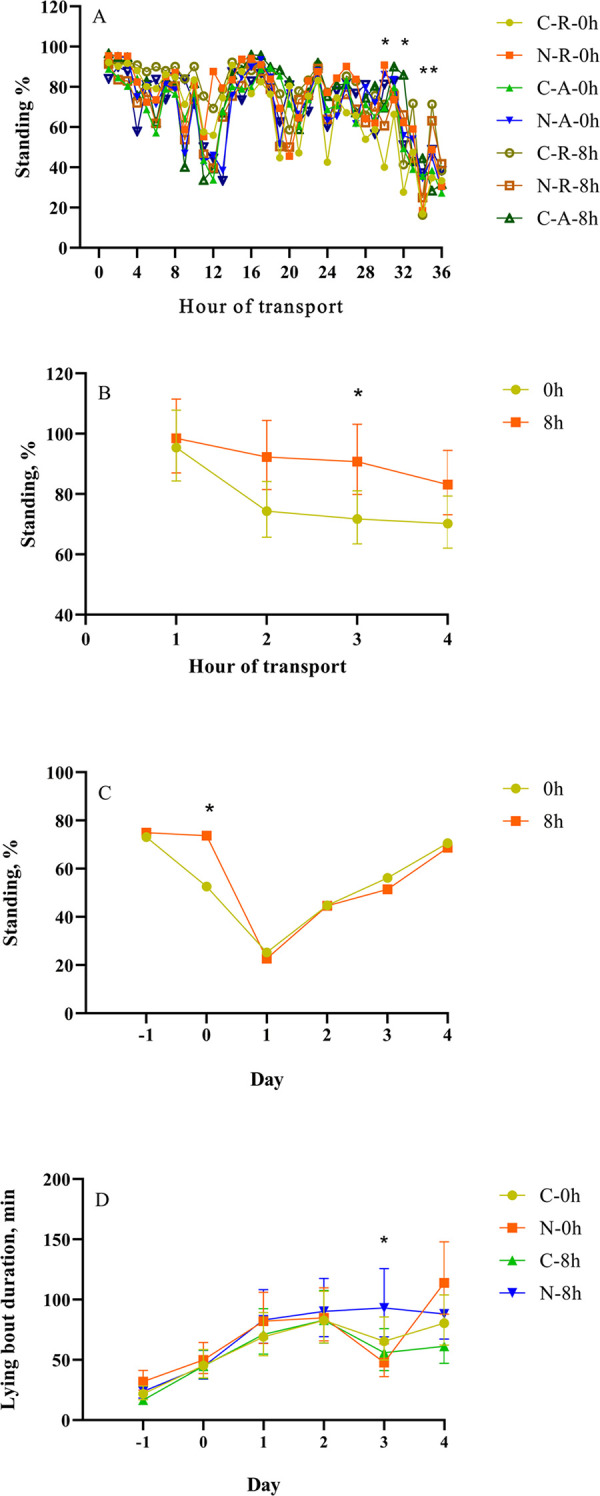
Least squares means (± upper and lower limits at 95% confidence) of standing duration (% of time) during the (A) 36 h transport, (B) additional 4 h transport, (C) first 4 days after transport and (D) lying bout duration of conditioned (C) and non-conditioned (N), auction market (A) and ranch direct (R) calves rested for 0 (0 h) or 8 (8 h) h.